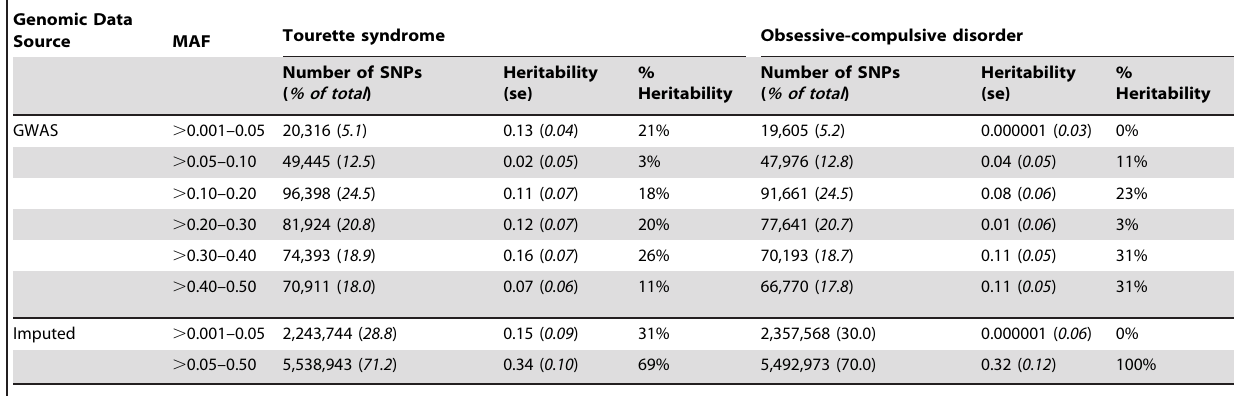
Table 2. GWAS and imputed heritability partitioned by minor allele frequency.